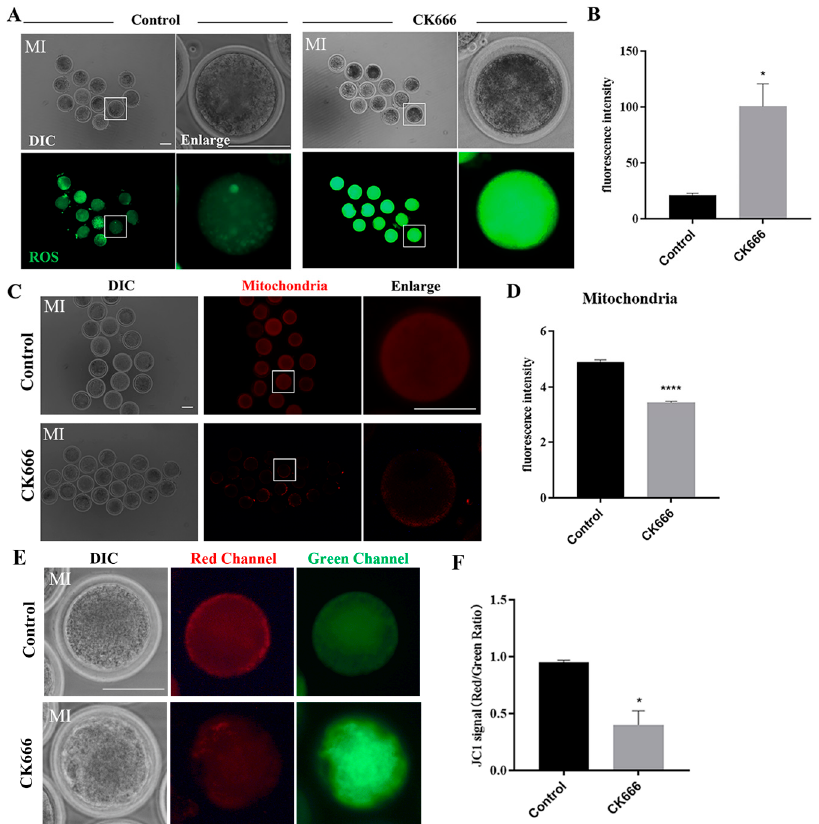
Figure 5. Inhibition of Arp2/3 complex affects mitochondrial functions in goat oocytes. ( A ) A selection of images of ROS fluorescence intensity in the control and CK666-exposed oocytes. Green: ROS. Bar = 100 µ m. ( B ) Analysis of fluorescent intensities of ROS revealed a distinction between the control group and CK666-exposed group. *, p < 0.05. ( C ) Representative images of mitochondria in the control and CK666-exposed oocytes. Bar = 100 μ m. ( D ) Analysis of the relative fluorescence intensity of mitochondria revealed a distinction between the control group and CK666-exposed group. ****, p < 0.0001. ( E ) The typical image for JC1 green channel and red channel in the control